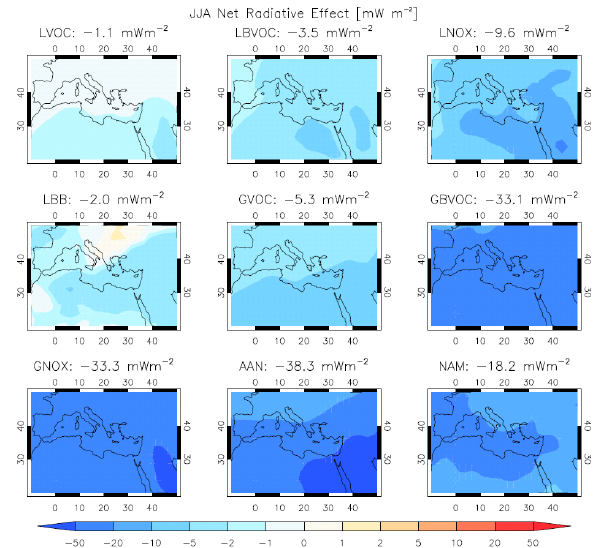
Fig 8. Summertime (JJA) net (longwave + shortwave) radiative effects (in mW m -2 ) over the 37 Fig. 8. Summertime (JJA) net (longwave + shortwave) radiative Mediterranean region at the top-of-the-atmosphere (TOA) for the nine emission reduction experiments 38 (see Table 2) compared to the 'Base' reference run. 39 effects (in mWm − 2 ) over the Mediterranean region at the top-of- the-atmosphere (TOA) for the nine emission reduction experiments (see Table 2) compared to the “Base” reference